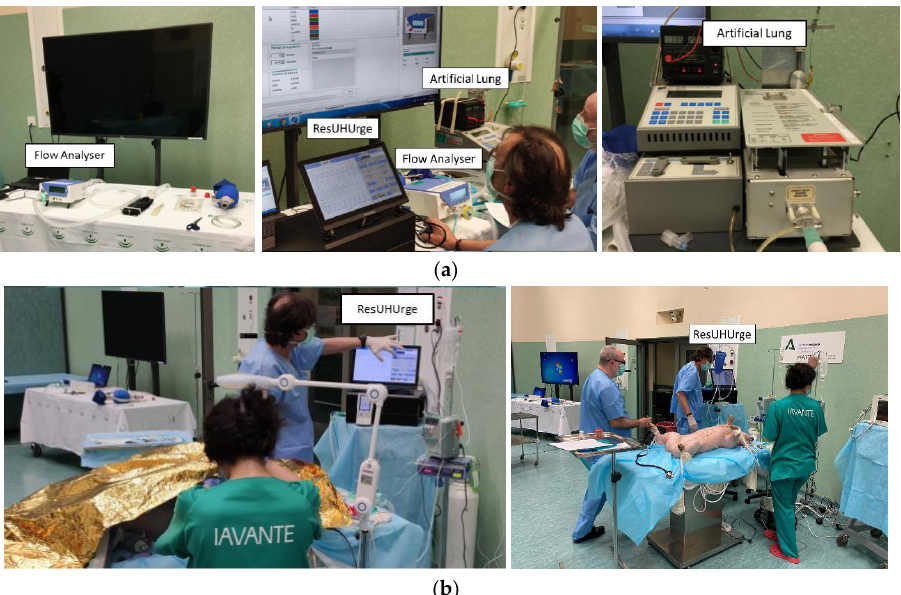
Figure A2 ( a ) Calibration test and artificial lung test; ( b ) animal test. Figure A2. ( a ) Calibration test and artificial lung test; ( b ) animal